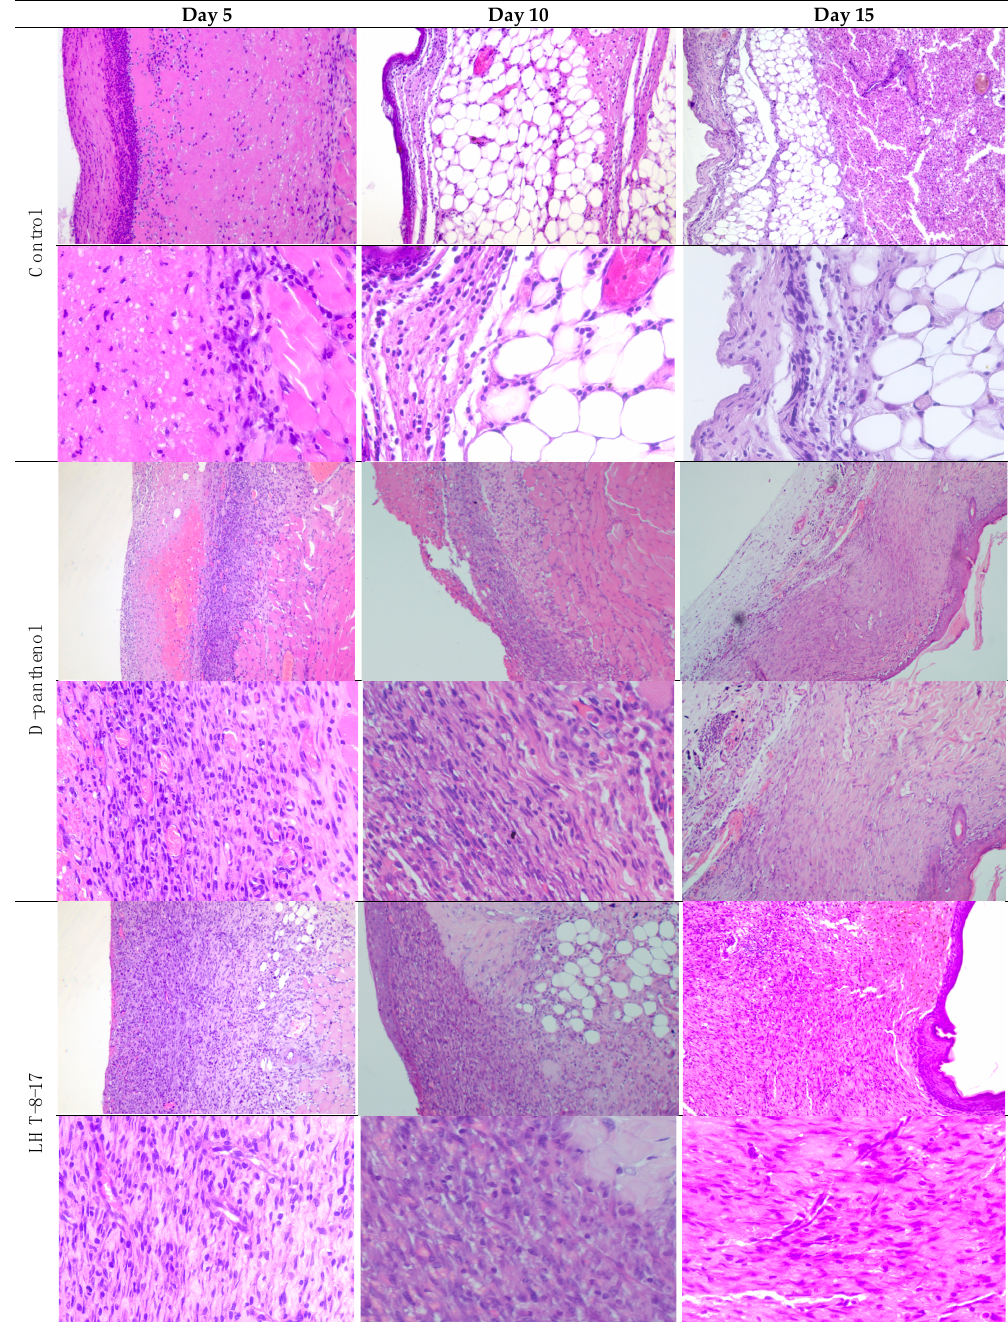
Figure 4. Micromorphology of repairing diabetic wound treated with LHT-8-17, db / db mice: hematoxylin and eosin, first line in each section—100×, second line in each section—400× (n = 5 in each subgroup). In control: on day 5, the wound bottom is covered by thick dense fibrin with many neutrophils in deep layers (black arrow) while the underlying layer has proliferating fibroblasts (red arrow); on day 10, the wound base is covered by immature granulation tissue, with a superficial thin layer of loose fibrin highly infiltrated by neutrophils (black arrow); underlying deep layers are infiltrated by macrophages, mast cells, lymphocytes, and fibroblasts involving subcutaneous fat tissue (red arrow); on day 15, the wound base central part is covered by fibrin threads, and slight epithelialization is developing on the periphery (black arrow); a thin layer of granulation tissue consists of macrophages, lymphocytes, and some neutrophils (red arrow). In the D-panthenol group: on day 5, thick fibrin with leukocytes covers the wound base, and an underlying thick layer of granulation tissue extends to the fascia propria (black arrow); granulation tissue contains macro- phages and lymphocytes, parallel oriented oval and spindle shaped fibroblasts, numerous engorged capillaries (red arrow); on day 10, the wound base is covered by fibrin threads with underlying immature granulation tissue characterized by cell infiltrate and numerous engorged capillaries,